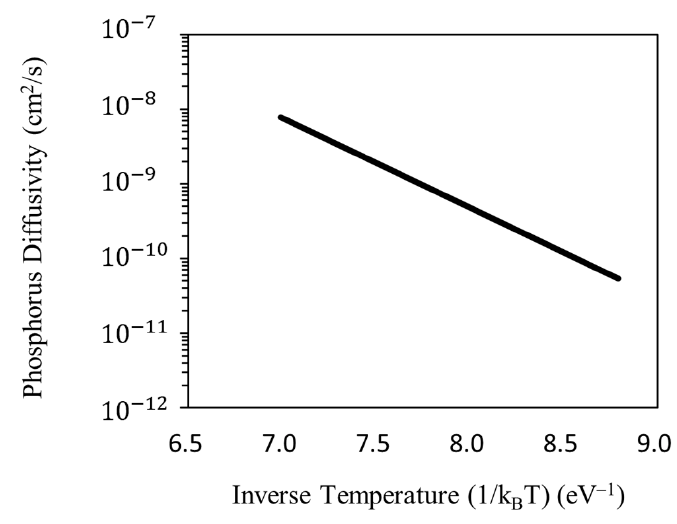
Figure 6. Arrhenius plot of phosphorus diffusivity.